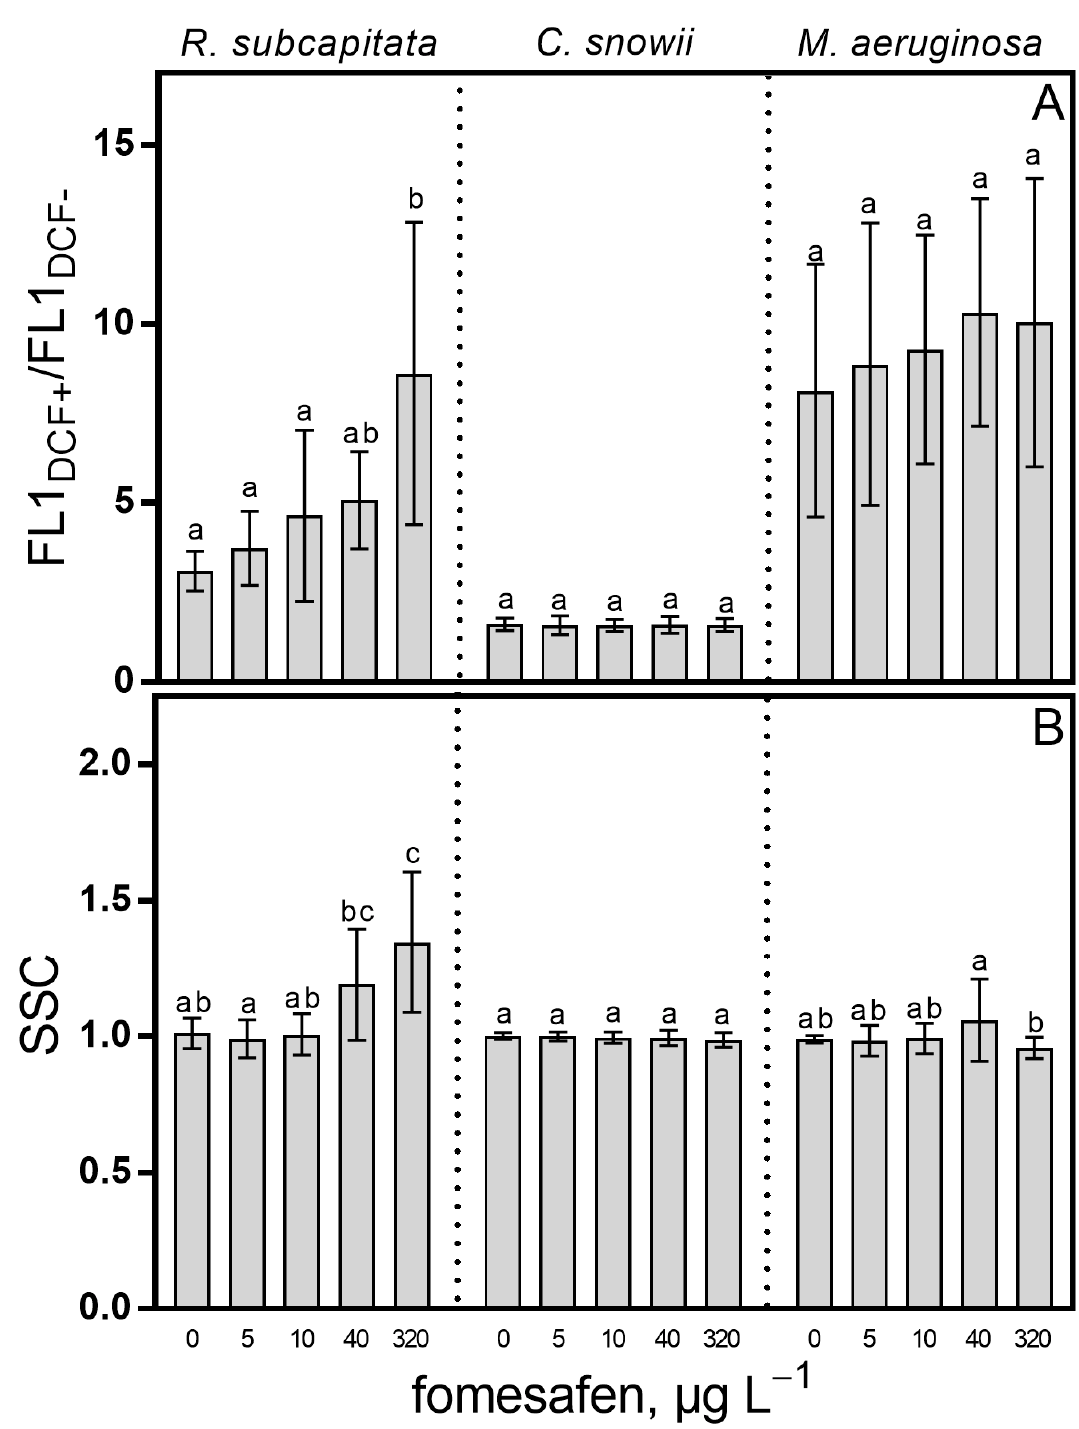
Figure 6. ( A ) Intracellular ROS content (FL1 DCF+ /FL1 DCF- ) and ( B ) cell complexity (SSC) of R. subcapitata , C. snowii and M. aeruginosa after 72 h exposure to five concentrations of fomesafen (0, 5, 10, 40 and 320 µg · L − 1 ). ROS content was measured as mean FL1 fluorescence of DCF positive cells divided by background mean FL1 fluorescence of fresh control culture. Cell complexity is represented by the mean side scatter parameter (SSC). Bars indicate the means ± standard deviation of nine repli- cates. Means followed by the same letter are not significantly different by the Tuker-Kramer HSD